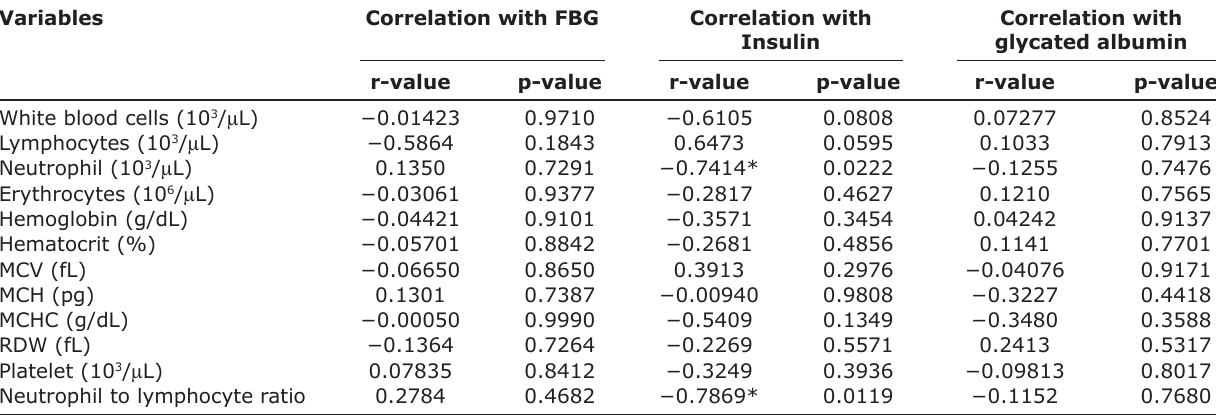
Table-3: Correlation of FBG, insulin, and glycated albumin versus hematological indices in normal control rats.